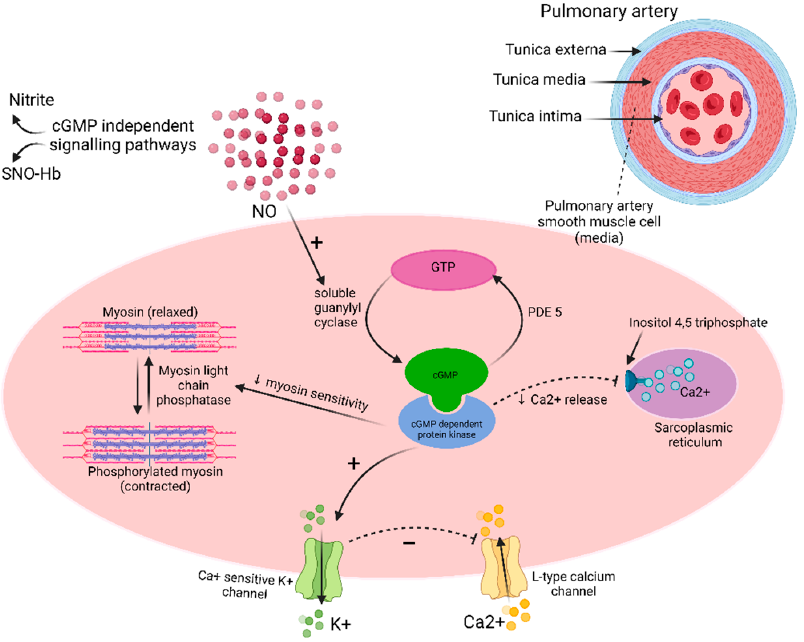
Figure 3. Role of nitric oxide in pulmonary arterial hypertension. SNO-Hb: S-nitroso-hemoglobin; NO: Nitric oxide; PDE: Phosphodiesterase; cGMP: Cyclic guanosine monophosphate; GTP: Guanosine triphosphate. “+” = stimulates, “ − ” =